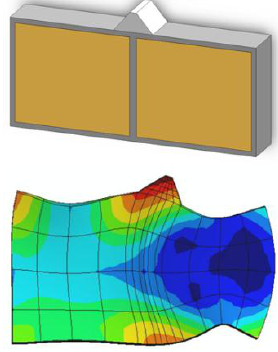
Figure 6. Single-mode excitation type ultrasonic motor from Physik Instrumente (PI). The excited single mode of the stator makes the pushing point to have an oblique impact to a sliding element